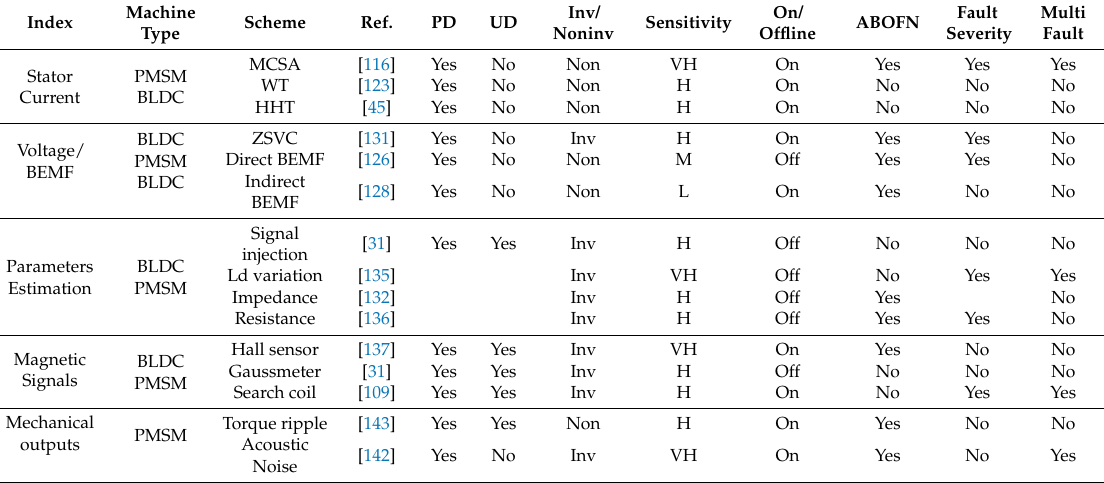
Table 2. Strengths and weaknesses of fault diagnosis techniques in the PM machine under